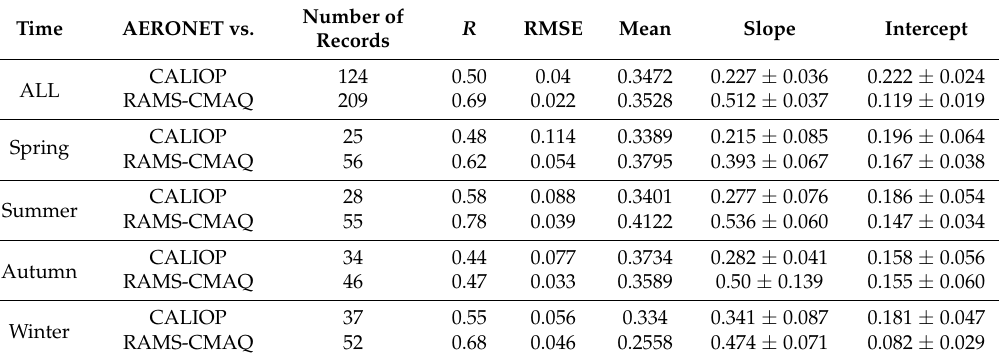
Figure 1. Comparisons of the monthly AERONET AOD means with the corresponding RAMS-CMAQ-simulated (red dots) and CALIOP-retrieved (blue dots) values for different seasons during the period from 2013 to 2015. ( a ) Spring (MAM); ( b ) summer (JJA); ( c ) autumn (SON); and ( d ) winter (DJF). Table 2. Statistics for the RAMS-CMAQ-simulated, CALIOP-retrieved, and AERONET AODs for the four seasons of 2013–2015.